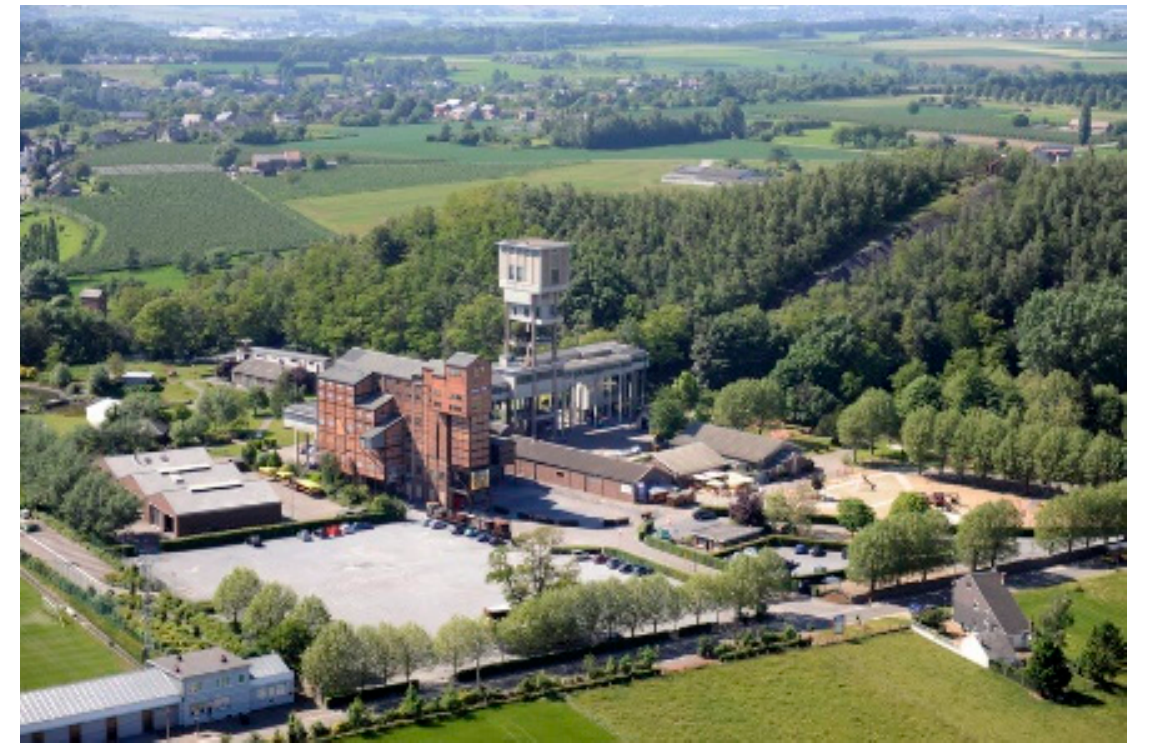
Figure 11. Aerial view of Blegny-Mine.